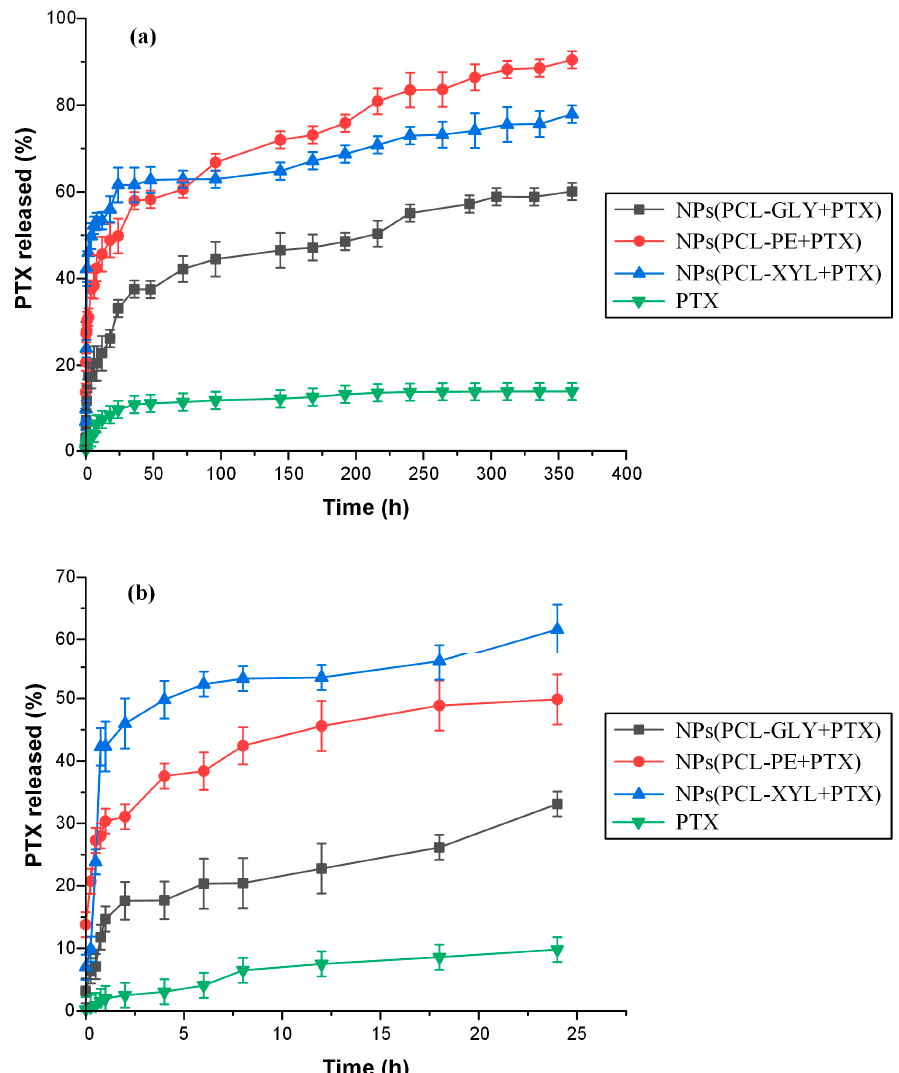
Figure 10. In vitro dissolution profiles of the neat PTX and the PTX-loaded NPs prepared with the synthesized PCL branched copolymers up to 15 days ( a ) and 1 day ( b ), respectively.